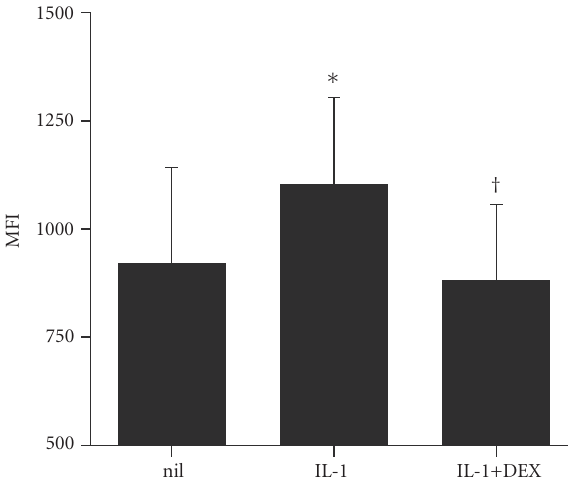
Figure 6: IL-1 β and DEX e ff ects on RA synovial fibroblast intracel- lular annexin I. RA FLS were cultured for 24 hours with interleukin- 1 β (IL-1, 1ng/mL), and/or DEX (DEX, 10 − 8 M). Annexin I pro- tein was detected by permeabilization flow cytometry and displayed as mean ± SEM mean fluorescence intensity (MFI). IL-1 β signifi- cantly increased intracellular annexin I ( ∗ P < . 01). The addition of DEX 10 − 8 M prevented the e ff ect of IL-1 β on intracellular annexin I ( † P < . 05) ( n =